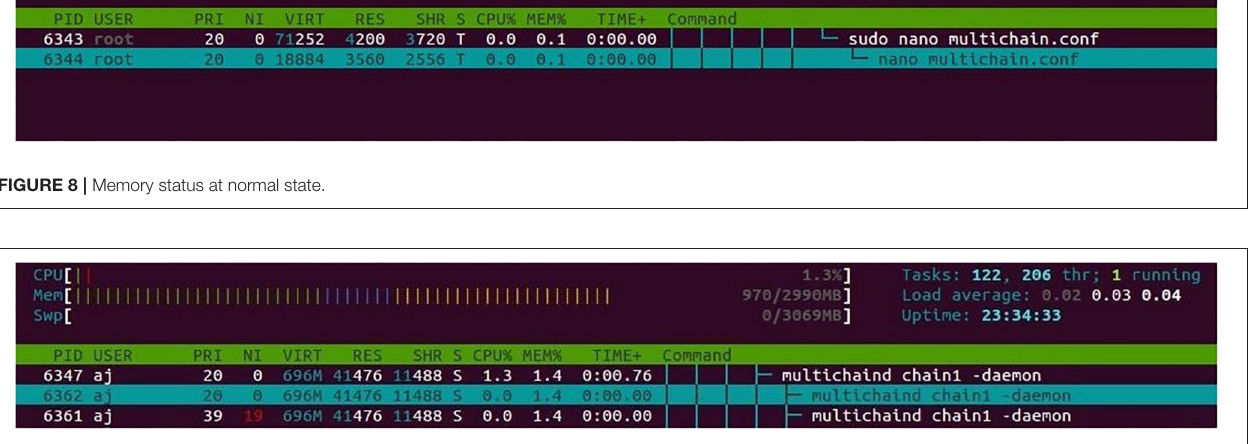
FIGURE 9 | Memory status after multichain daemon